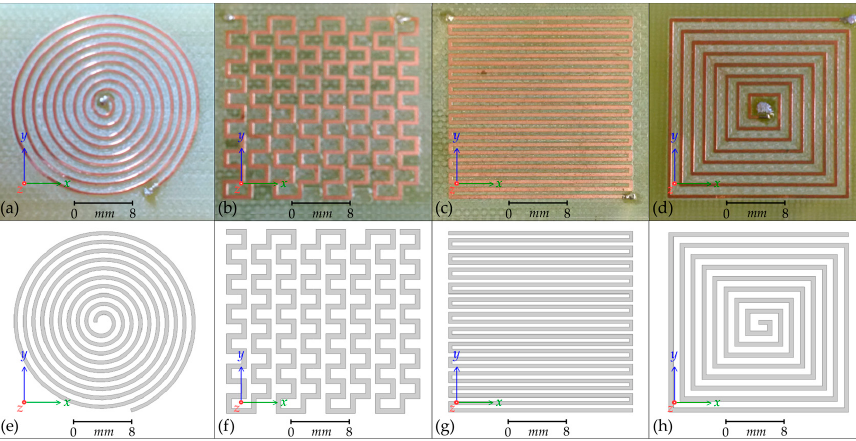
Figure 1. Photographs of the four manufactured planar coils together with the equivalent ANSYS ® 3D finite-element models: ( a , e ) Circular planar coil; ( b , f ) Mesh planar coil; ( c , g ) Meander planar coil; ( d , h ) Square planar coil. The solder points for the energizing connections can be seen. The wires exit beneath.